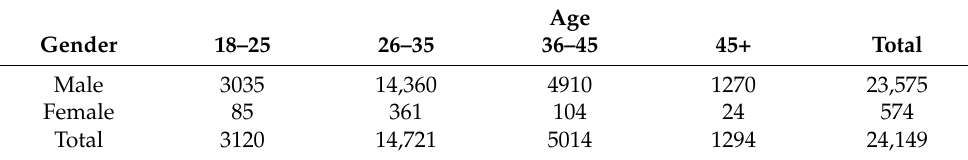
Table 4. Age and gender distribution.